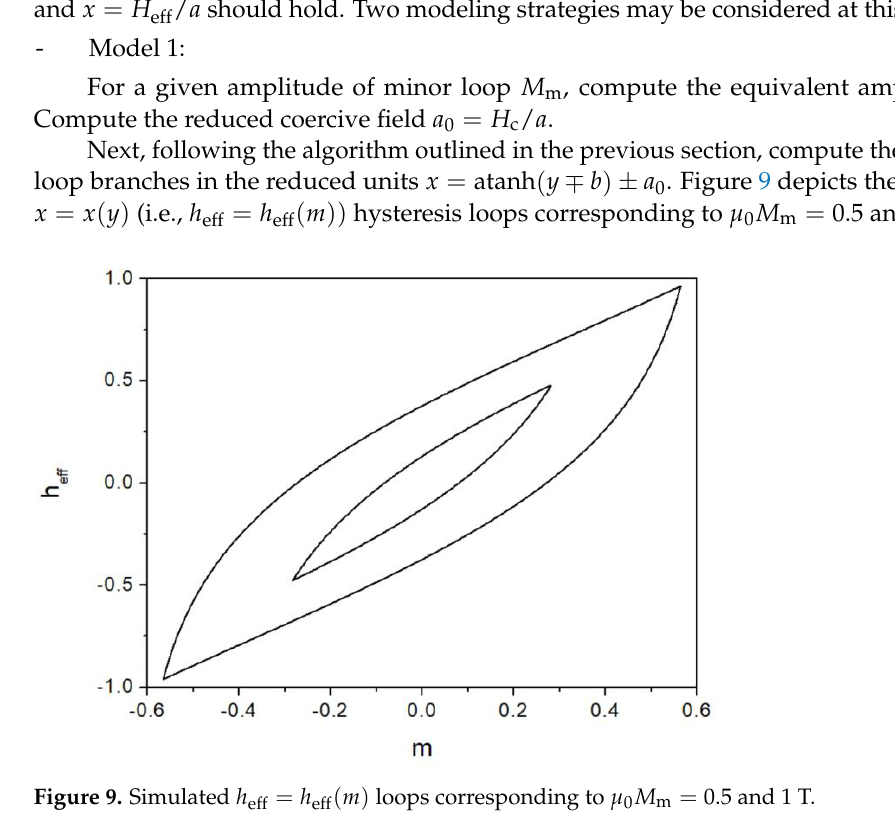
Figure 9. Simulated h eff = h eff ( m ) loops corresponding to µ 0 M m = 0.5 and 1 T. Substituting back M = yM s and H = ax − α M , we obtain the sought hysteresis minor loop in physical units.